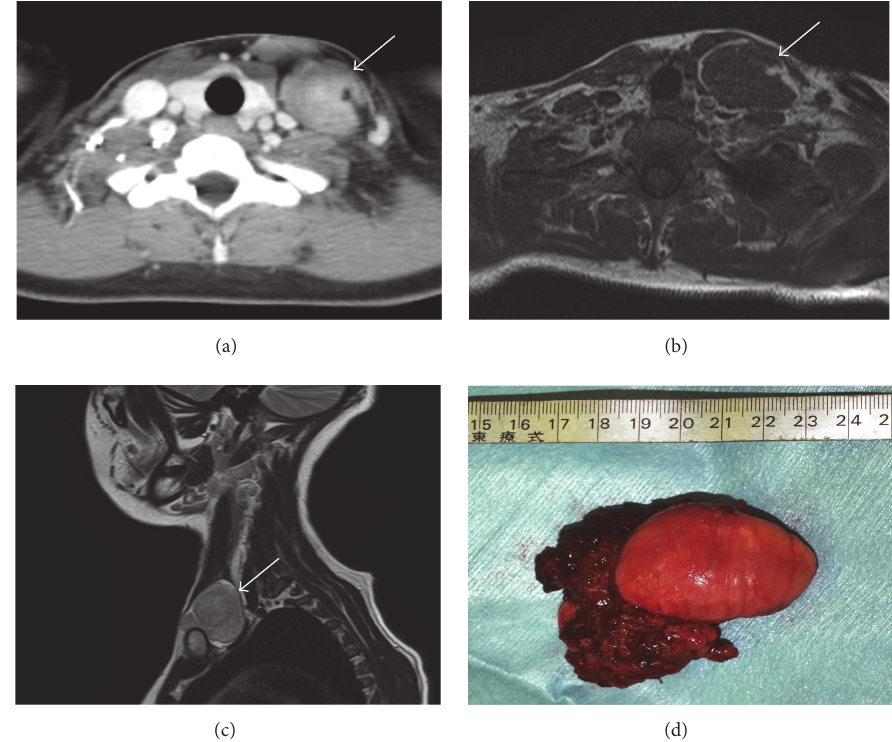
Figure 3: Preoperative imaging findings for Case 2. (a) Contrast-enhanced computed tomography image. T1-weighted axial (b) and T2- weighted sagittal (c) magnetic resonance images. Computed tomography and magnetic resonance images show a tumor with a clear margin and intralesional adipose tissue in the left lower neck. (d) Gross findings of the tumor. The tumor was encapsulated and had a smooth external